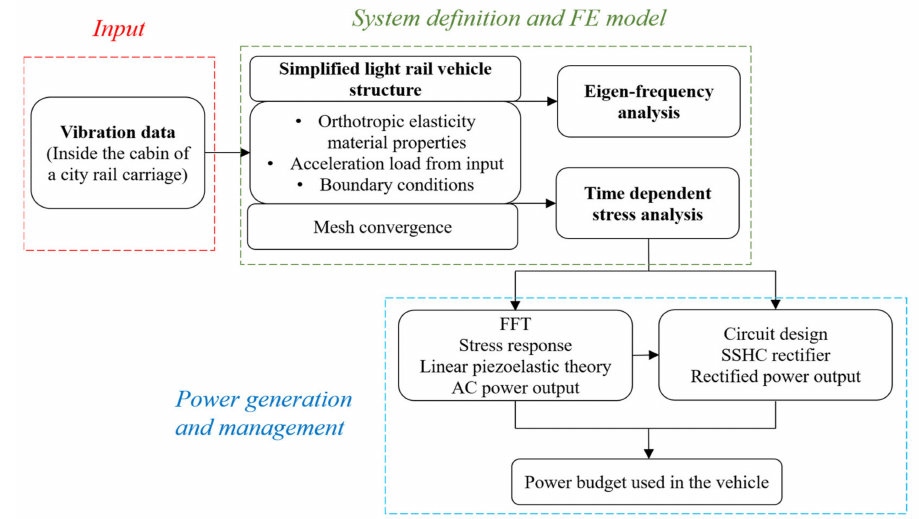
Figure 3. The schematic of the FE model setup and power prediction from the piezoelectric MFC on composite rail chassis when subjected to vibrational data input discussed in this paper.